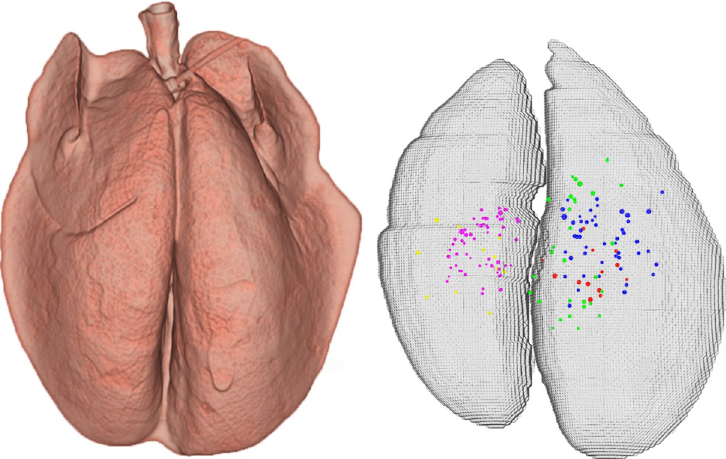
Fig 2. Summary of experimental results. Left: CT image reconstruction of a minipig’s pulmonary surface. Right: 3D representation of location and size of all minipig lesions; each colour is for a different minipig (red, magenta, blue, yellow, and